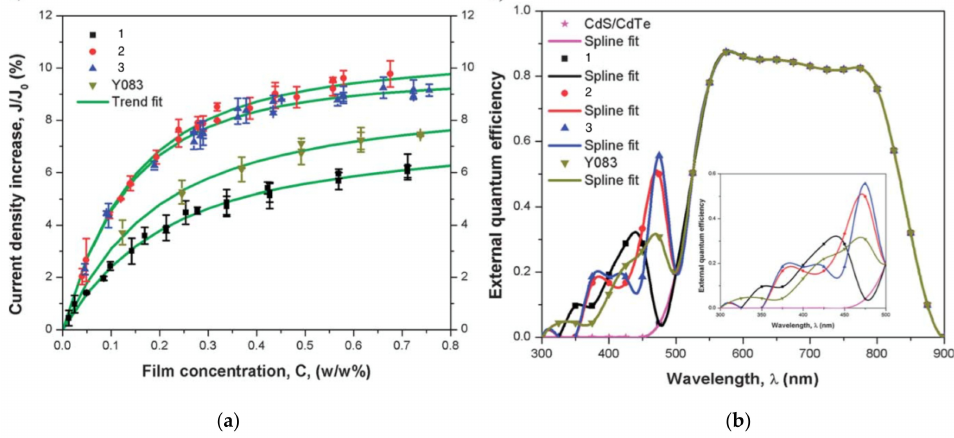
Figure 3. ( a ) The increase of short circuit current density ( J sc ) vs. the different concentrations of the LDS film placed on the CdTe solar cell surface for fluorophores 1–3 and Y083; ( b ) The enhanced spectral response at short-wavelengths after the LDS film was placed on the CdTe solar cell surface for fluorophores 1–3 and Y083. (reprinted with permission from ref. [17], Copyright 2013 Royal Society of